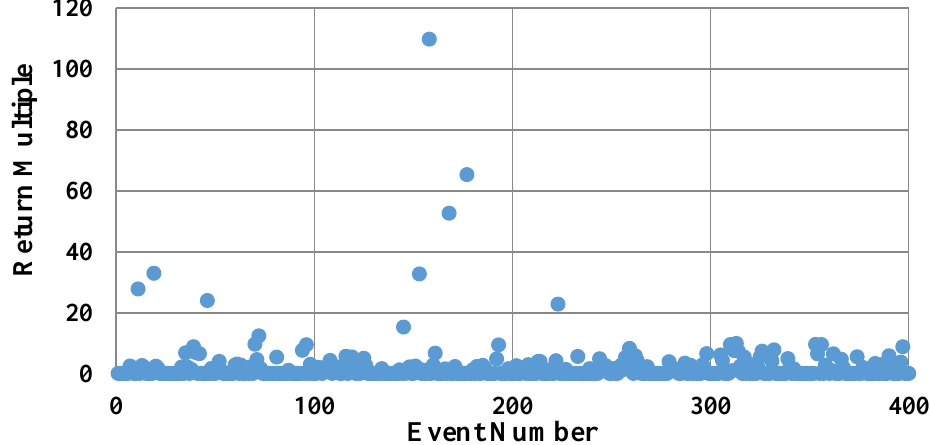
Figure 6. Monte Carlo simulation of 400 portfolio-driven events.